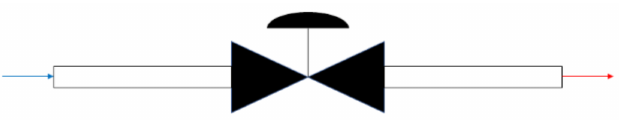
Figure 5. Pressure reducing valve.